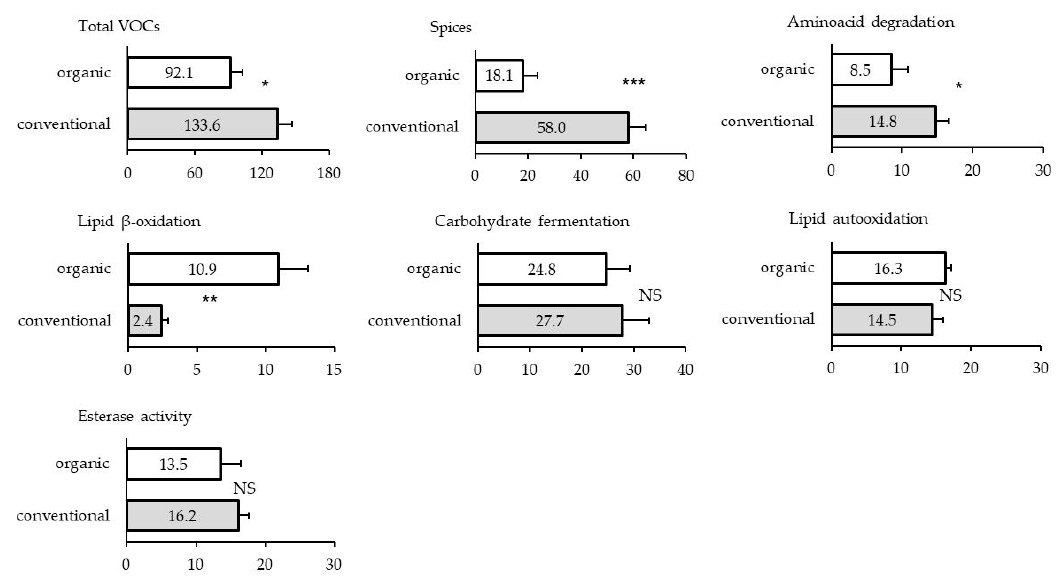
Figure 1. Relative abundance of groups of volatile compounds (VOCs) in dry-fermented sausages (six per treatment group) according to pig husbandry practice (organic or conventional). (NS – p > 0.10, *